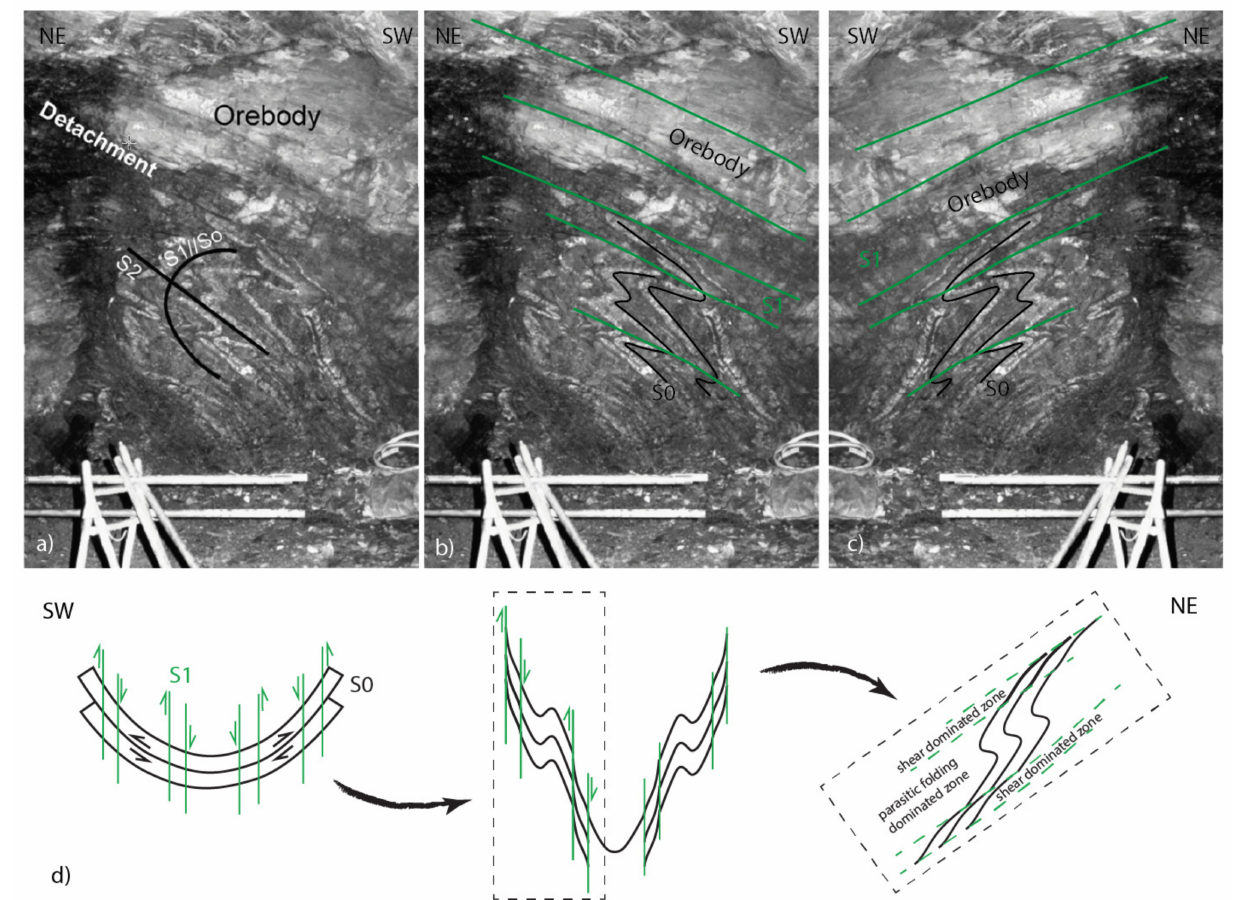
Figure 12. Re-interpretation of the current tectonic model. ( a ) Adapted with permission from [2] (Elsevier, 10 May 2021); ( b ) A new interpretation of the same photograph; ( c ) Rotation of the original picture and the new interpretation to the commonly used orientation looking NW; ( d ) A conceptual tectonic sketch is showing the development of parasitic folds and axial planar foliation S1 as well as subsequent rotation to the final